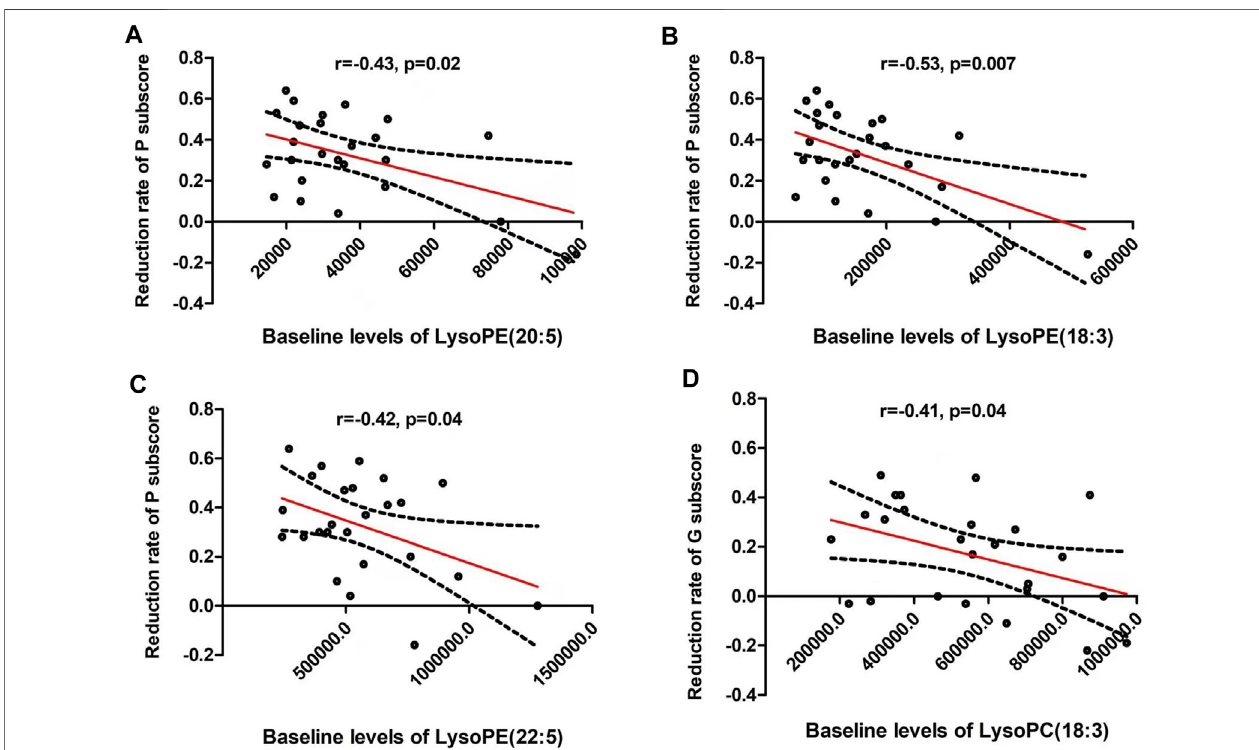
FIGURE3| ThereductionrateofPANSSpositivesubscorewasnegativelycorrelatedwithbaselinelysophosphatidylethanolamine(LPE)(20:5)( r (cid:2) − 0.47, p (cid:2) 0.02) (A) , LPE (18:3) ( r (cid:2) − 0.53, p (cid:2) 0.007) (B) and LPE (22:5) ( r (cid:2) − 0.42, p (cid:2) 0.04) (C) . In addition, LPC(18:3) was negatively correlated with the reduction rate of general psychological subscore ( r (cid:2) − 0.41, p (cid:2) 0.04) (D) . The red line represents the trend line, and the dashed black line is the 95% con fi dence interval.